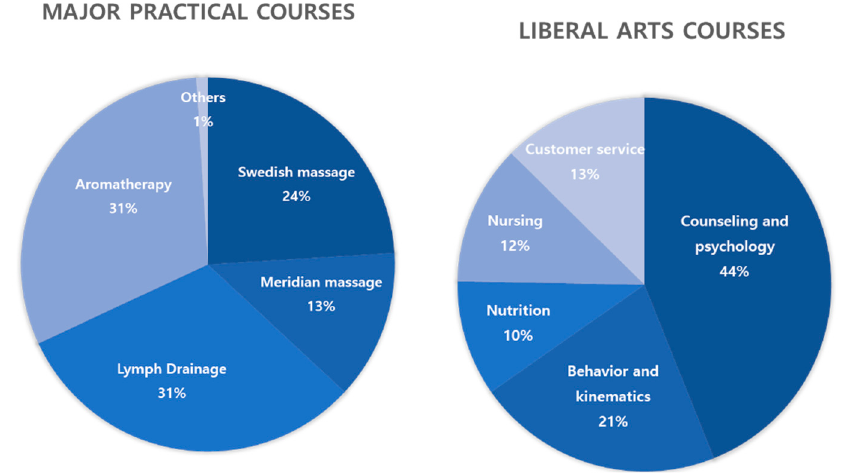
Figure 3. Major and liberal arts courses that are considered necessary for senior beauty services.